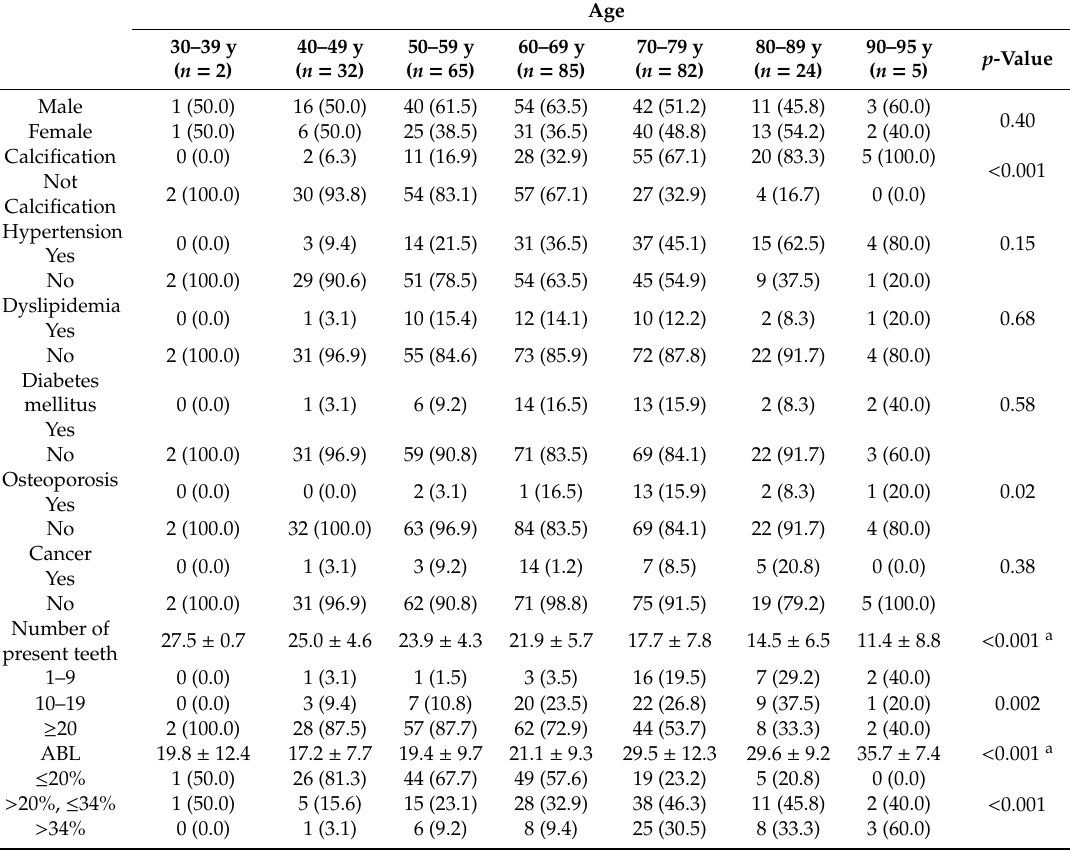
Table 1. The characteristics of all participants by age